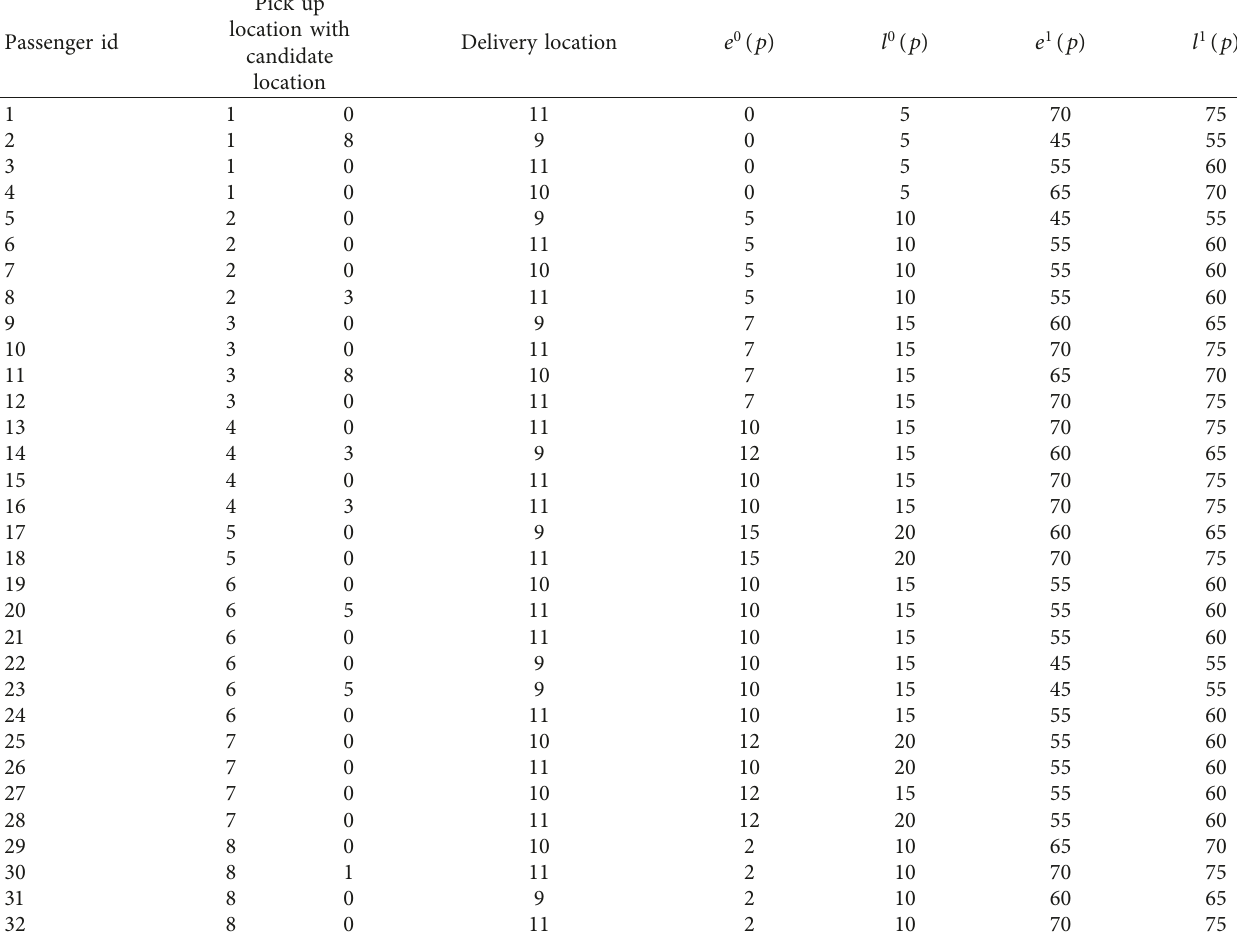
Table 14: Passenger demands information of Group 2.